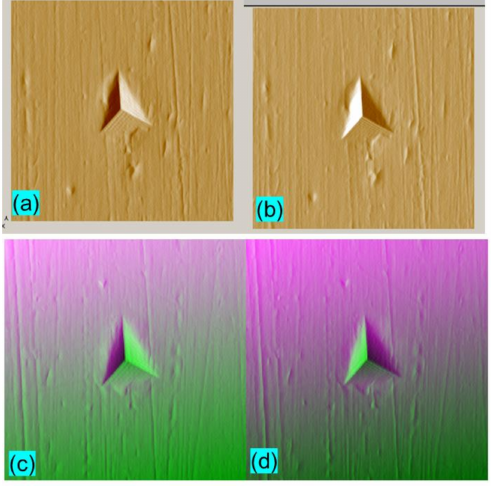
Figure 5. ( a , b ): System-generated image [26,27]; ( c , d ): predicted image (current work) for maximum applicable load of 2000 µ N and 30 s holding time.